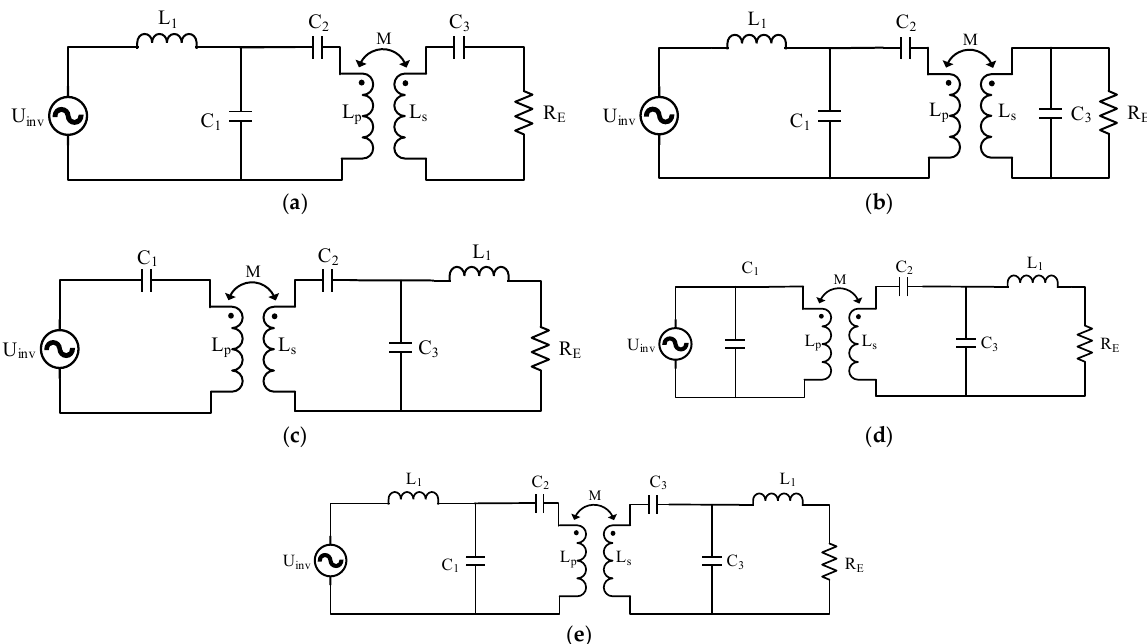
Figure 11. LCC type high-order hybrid resonance compensation structure. ( a ) LCC-S Compensation structure; ( b ) LCC-P Compensation structure; ( c ) S-LCC Compensation structure; ( d ) P-LCC Compensation structure; ( e ) LCC-LCC Compensation structure.